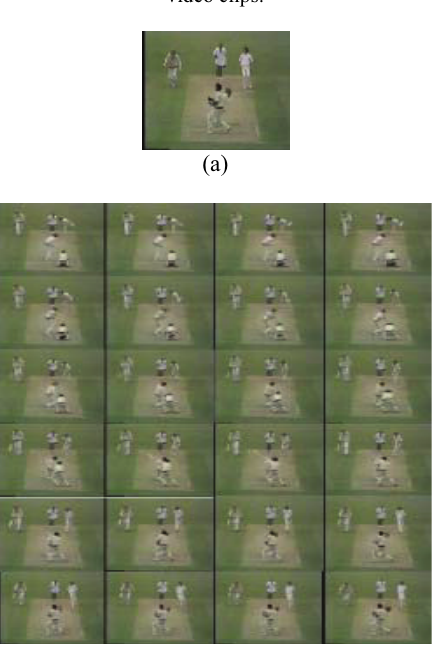
Fig. 6 (a) Results of the proposed CBVR system over games database: (i) input query clip and (ii) some of the retrieved video clips.